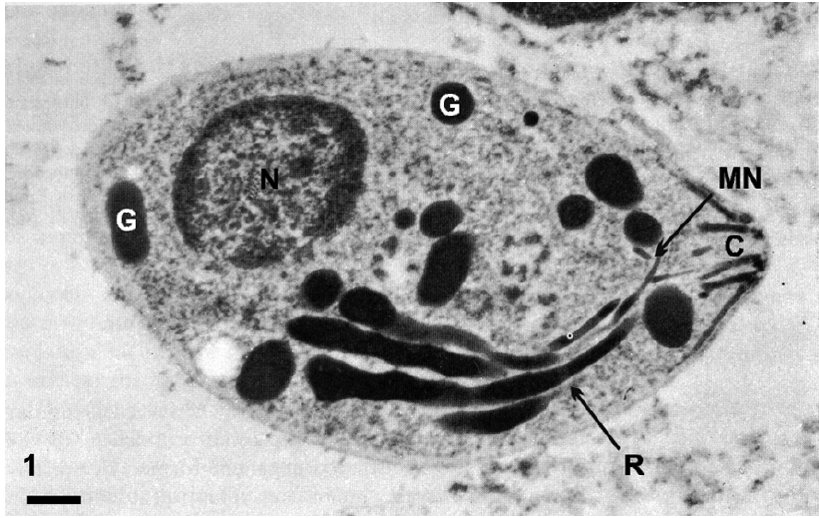
Fig. 1 – Transmission electron microscopy of a tachyzoites of Toxoplasma gondii submitted to the ethanolic phosphotungstic acid technique, which labels structures containing basic proteins. In addition to the nucleus (N), staining of the dense granules (G), Rhoptries (R), Micronemes (M) and the Conoid (C) is observed. Bar, 0 . 3 µ m. After De Souza and Souto-Padrón